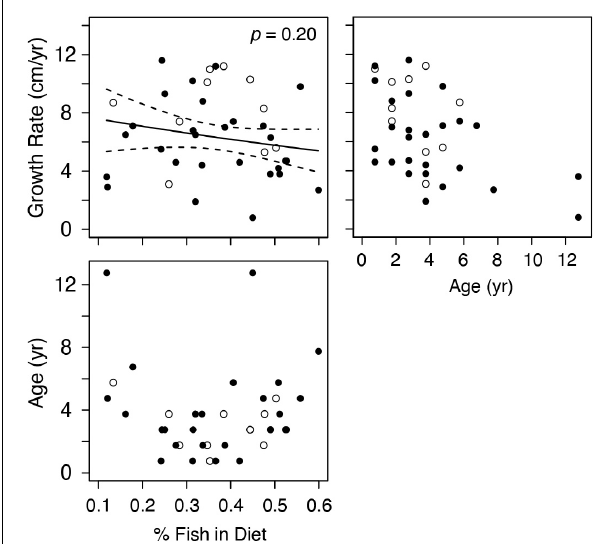
FIGURE 5 | Generalized Linear Model results examining the relationship between annual Kemp’s ridley sea turtle growth rates and proportional contribution of fish to western Gulf of Mexico turtle diets. Diet estimates are derived from a stable isotope mixing model that included informative priors. Data are for the most recently deposited growth layer prior to death only. Closed circles are true annual growth rates (i.e., turtle stranded in spring, yielding a complete growth interval). Open circles are estimated annual growth rates for turtles that stranded during the winter (November–March); we assumed that annual skeletal growth asymptotes in November (see section “Somatic Growth Rates in Materials and Methods”).